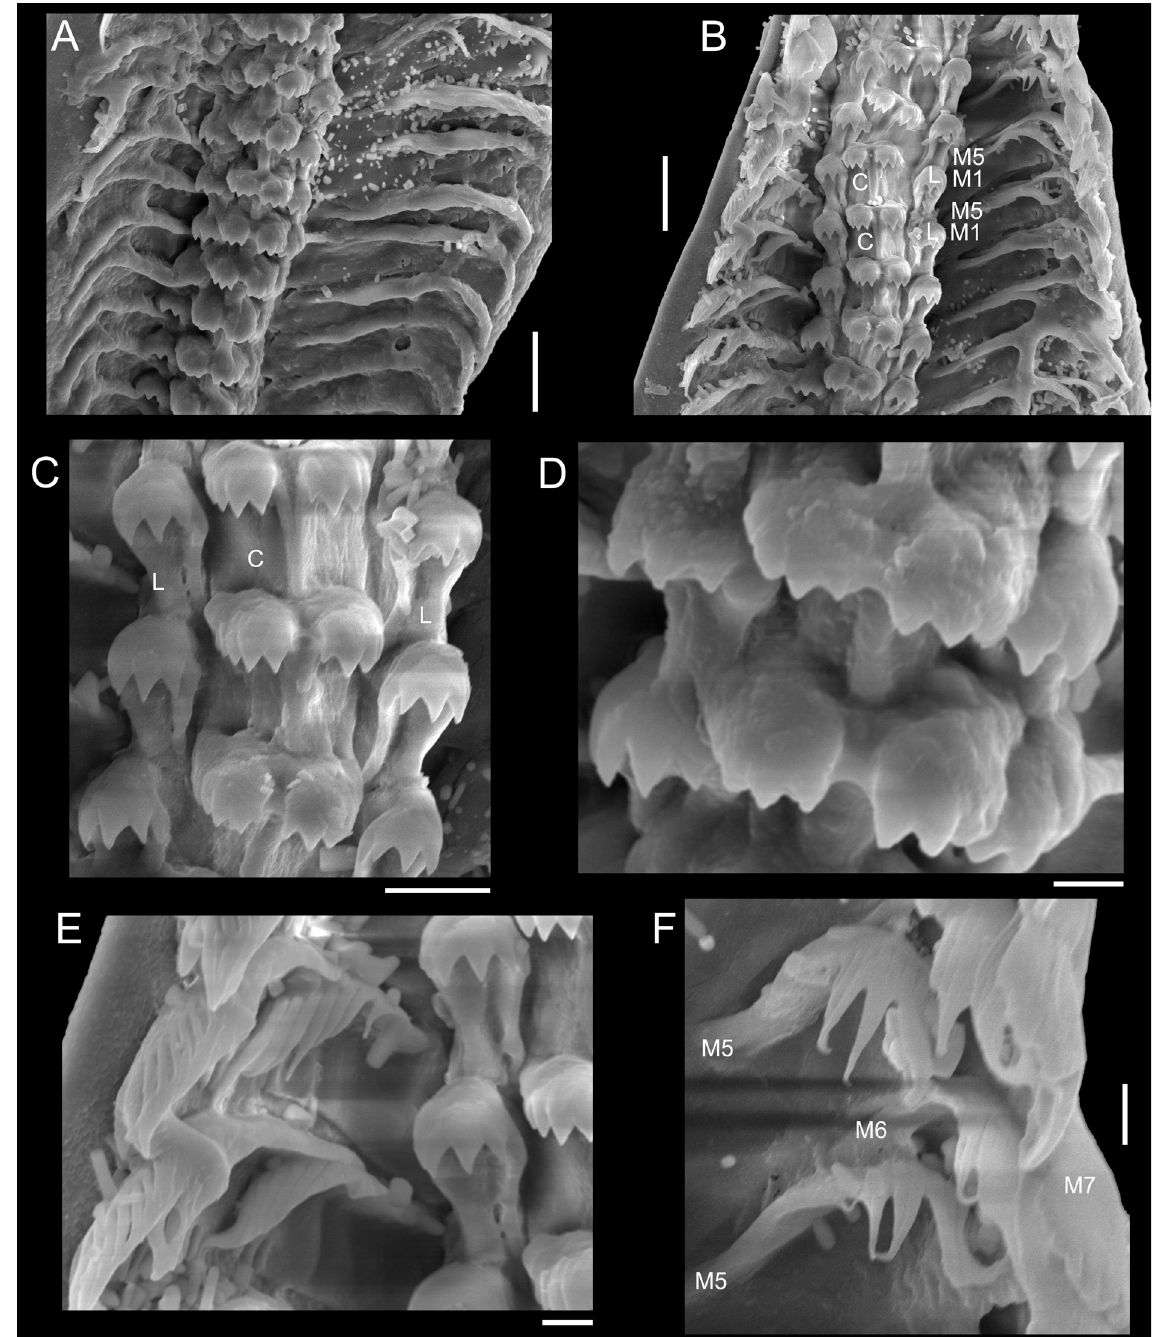
Fig. 24. Sagenotriphora osclausum (Rolán & Fernández-Garcés, 1995), radula. A–F . MNRJ 35061. Scale bars: A–B = 10 µm; C = 5 µm; D–F = 2